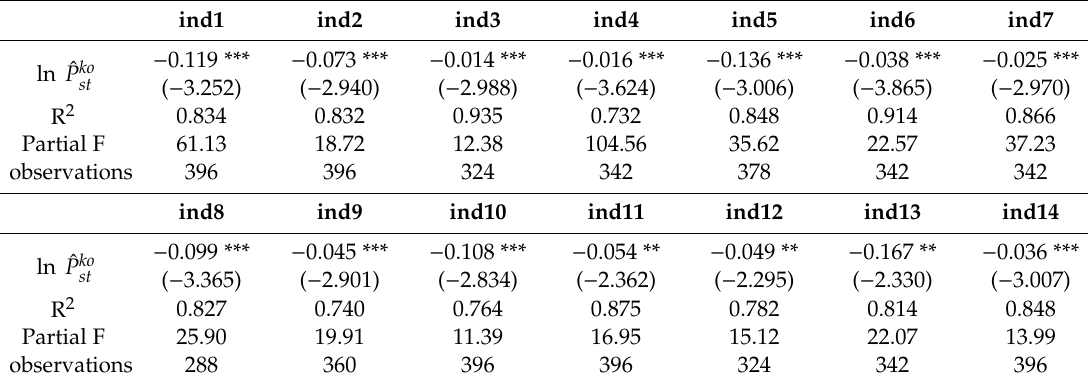
Table 3. The result of the two-stage least squares (2SLS)